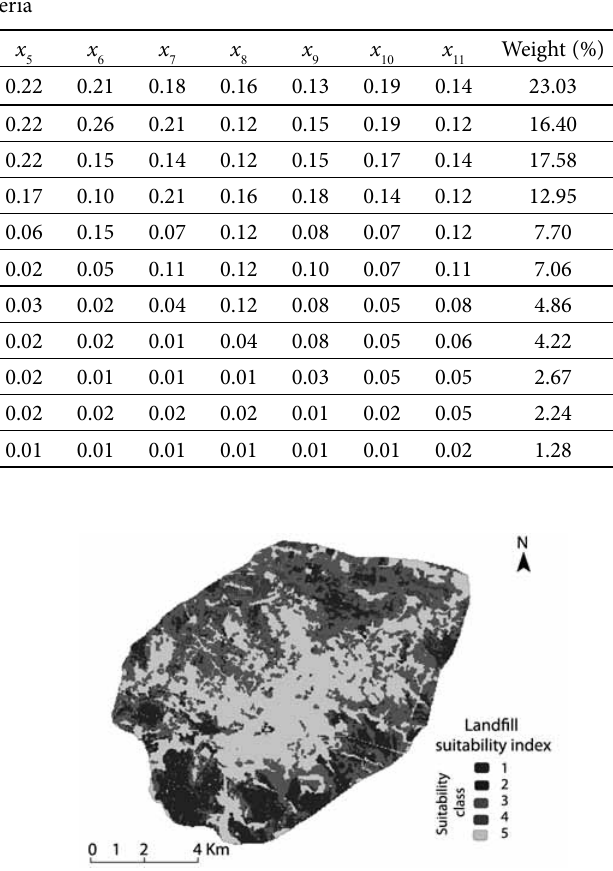
Fig. 5. Landfill suitability index